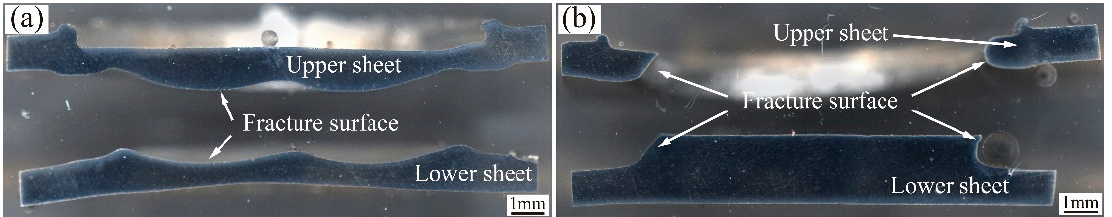
Figure 10. Macrostructures of cross sections for two typical fracture modes: ( a ) shear fracture and ( b ) plug fracture.